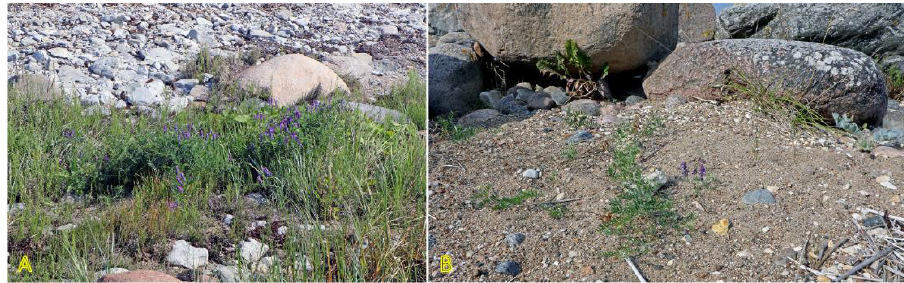
Figure 20. Vicia cracca in a coastal depression with perennial vegetation on a shingle beach on the island of Saaremaa, Estonia ( A ) and on a sandy beach on the island of Kihnu, Estonia ( B ).